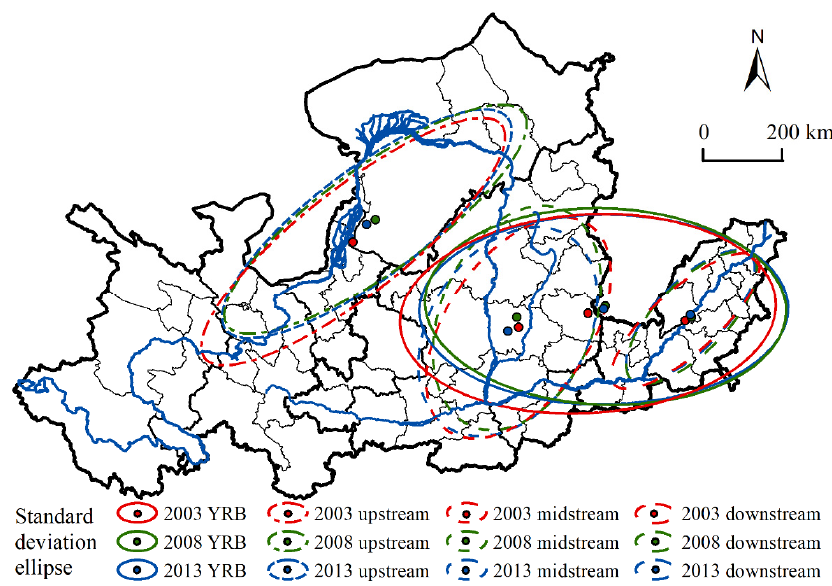
Figure 3. Output value and water pollution-intensive index of WPIIs by industry in 2013. All WPIIs in the YRB show a significant east-west spatial distribution pattern from 2003 to 2013 (Figure 4). The distribution center was basically located in the boundary between the middle and lower reaches, and the one-time standard deviation ellipse mainly covered the middle and eastern regions of the middle reaches and the lower reaches. During the study period, the long semi-axis decreased and the industries were clustered along the east-west direction. Overall, the WPIIs were clustered in the eastern and downstream areas of the middle reaches of the basin.